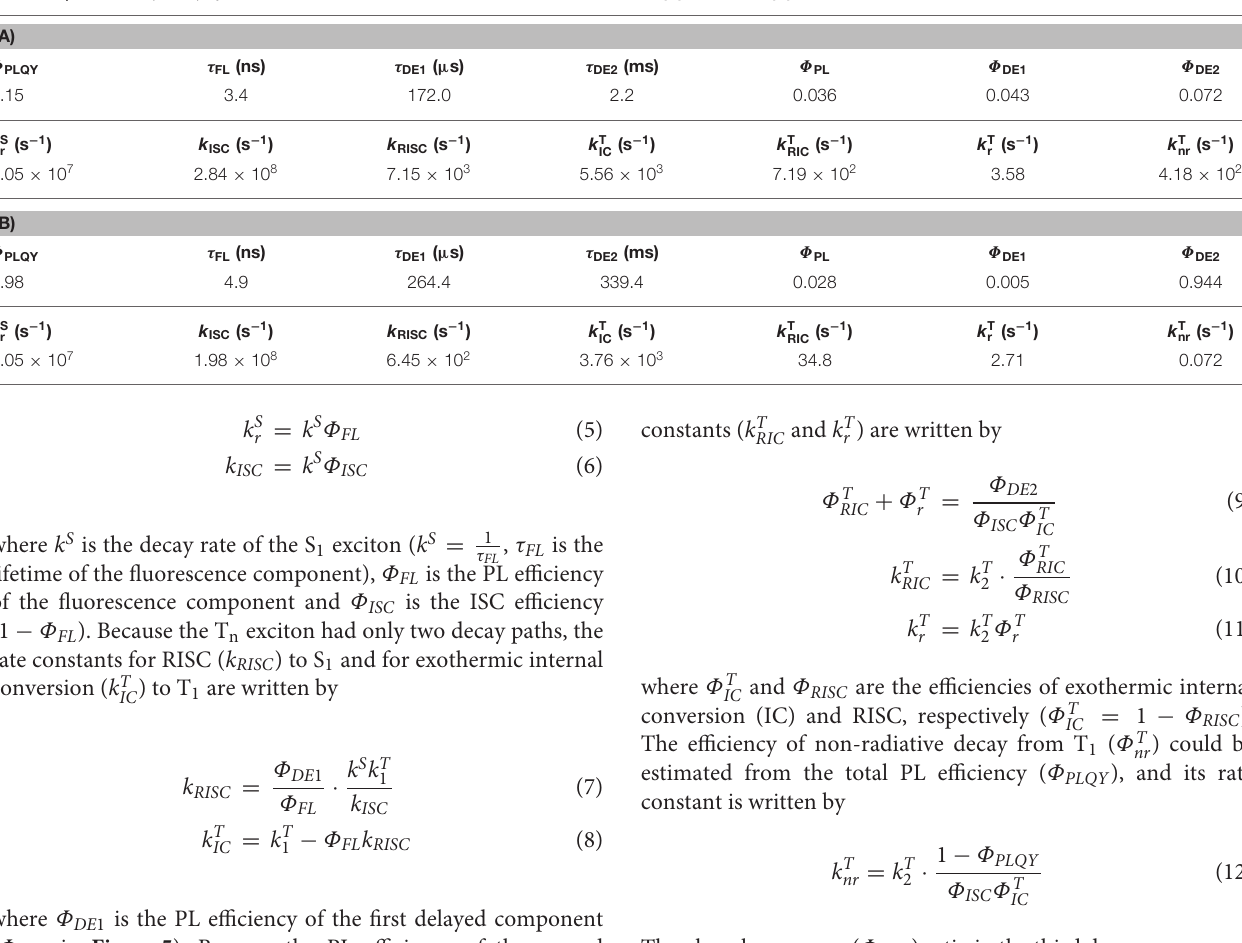
TABLE 2 | Observed photophysical values and rate constants of 6 wt% 7: DPEPO film at (A) 300K and (B)